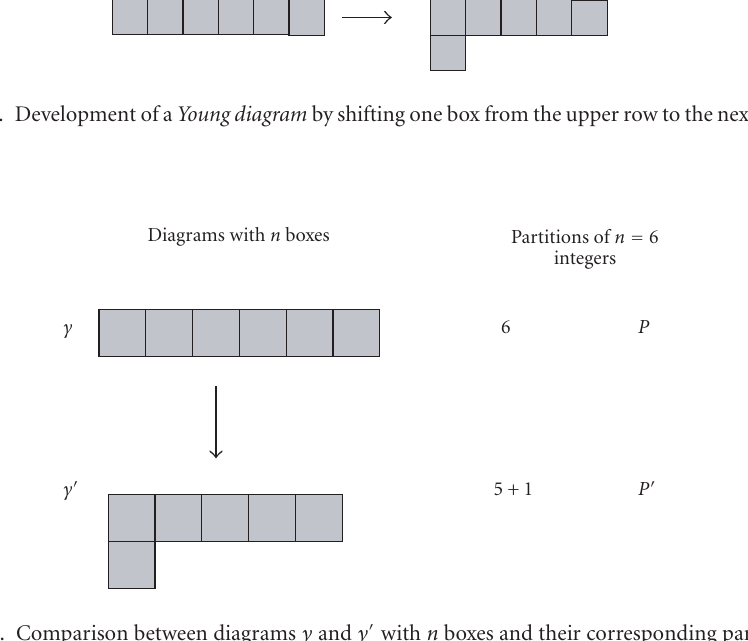
Figure 4.4. Comparison between diagrams γ and γ (cid:11) with n boxes and their corresponding partitions P and P (cid:11) of n = 6 integers. The unequality relations γ ⊃ γ (cid:11) and P ⊃ P (cid:11) hold,